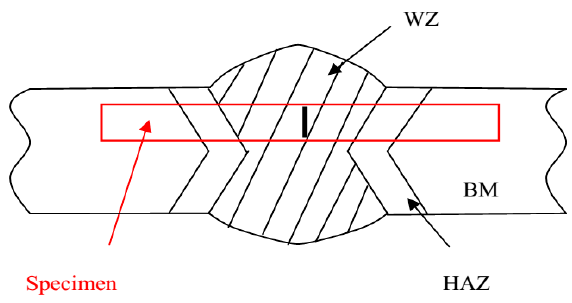
Figure 1. Schematic diagram for sampling method of the impact specimens (WZ: weld zone; HAZ: heat affected zone; BM: base